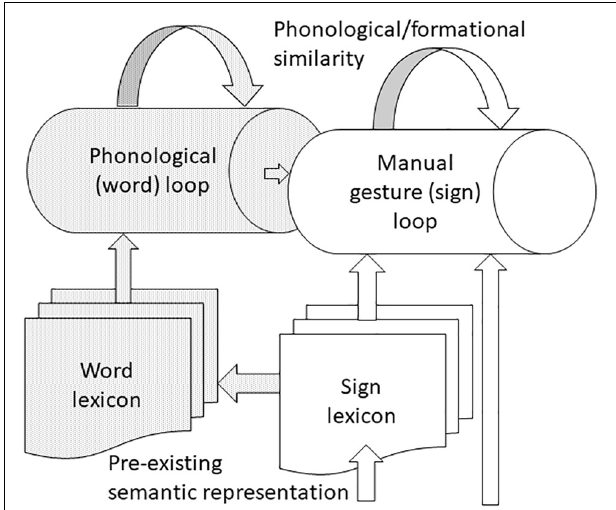
FIGURE 4 | Working memory for linguistic and non-linguistic manual gestures. Manual gestures enter the corresponding loop either directly, if they are non-linguistic, or via the sign lexicon for individuals with pre-existing semantic representation. Bimodal bilinguals have the option of recoding signs as their word glosses and processing them via the word loop. Both loops are subject to negative effects of phonological/formational similarity, but while phonological familiarity aids processing in the word loop, this does not seem to be the case in the sign loop. Deafness leads to greater capacity of the sign loop, probably due to reliance on visual information and expert knowledge of sign